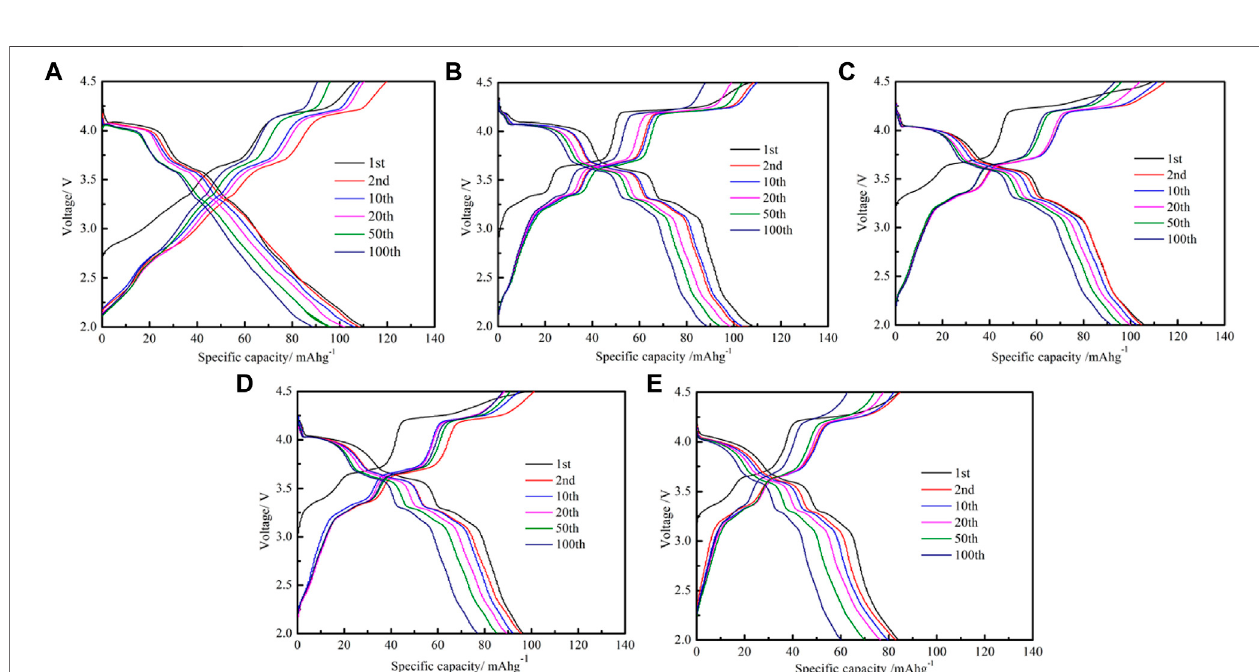
FIGURE 6 | Charge/discharge pro fi les of NM and MgO-coated samples. (A) NM; (B) 1 wt%; (C) 2 wt%; (D) 3 wt%; (E) 4 wt%.